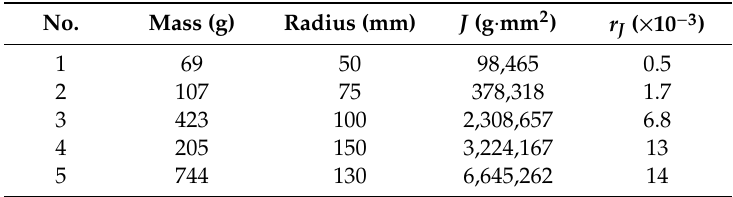
Table 1. Parameters of rotary inertia.